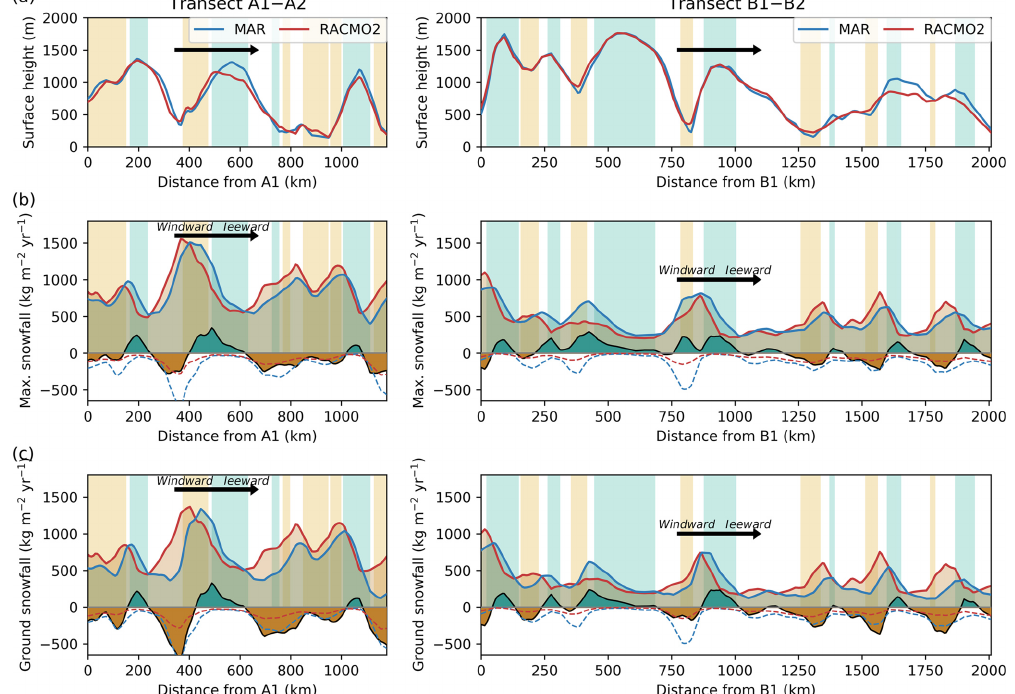
Figure 6. MAR- and RACMO2-simulated fields for the year 2015, extracted with a bilinear interpolation for (left) transect A1–A1 and (right) transect B1–B2 (locations shown in Fig. 5b and d). Each panel shows MAR fields (blue lines) and RACMO2 fields (red lines) for (a) surface height, in metres above sea level; (b) maximum snowfall amounts, equal to ground snowfall plus atmospheric sublimation, in kgm − 2 yr − 1 ; and (c) snowfall amounts at the ground, in kgm − 2 yr − 1 . In (b) and (c) , the thick black line is for the difference in snowfall between MAR and RACMO2 (MAR-RACMO2), with green-filled areas when MAR snowfall is larger than RACMO2 snowfall, and brown-filled areas when MAR snowfall is lower than RACMO2 snowfall (same convention as in Fig. 5); the dotted lines are for the atmospheric sublimation modelled by MAR (blue) and by RACMO2 (red), negative when it induces a decrease in precipitation; light coloured bands show crests (light blue, curvature of MAR topography greater than 0 . 005 10 − 6 m − 1 ) and valleys (light yellow, curvature of MAR topography lower than − 0 . 005 10 − 6 m − 1 ). The thick black arrows show the main 800hPa wind direction during cyclonic